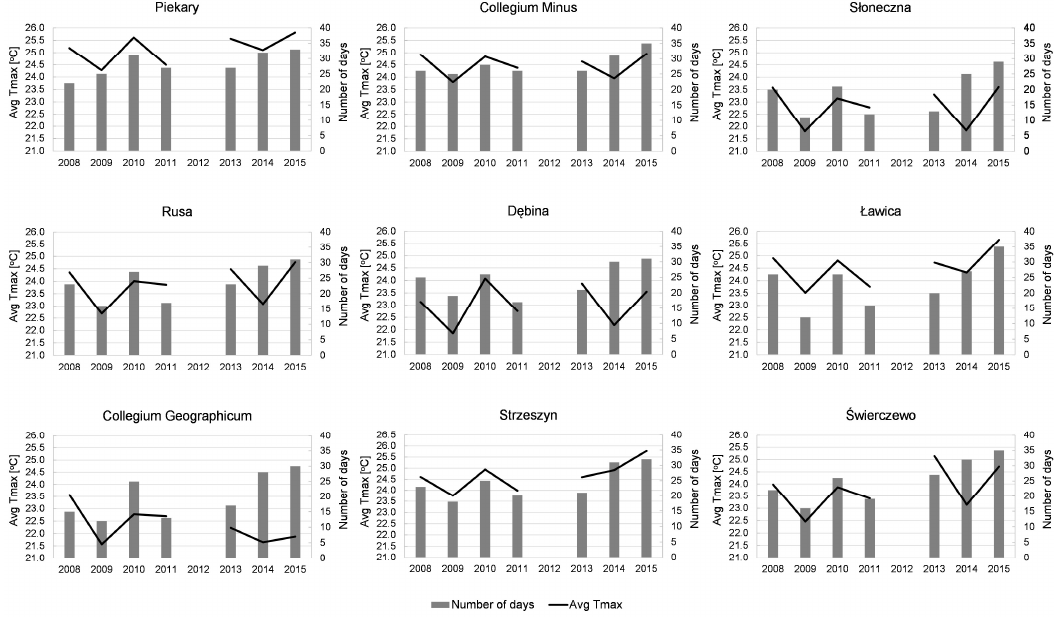
Figure 4. Average T max in the summer season and the number of hot days in 2008–2015 in the city